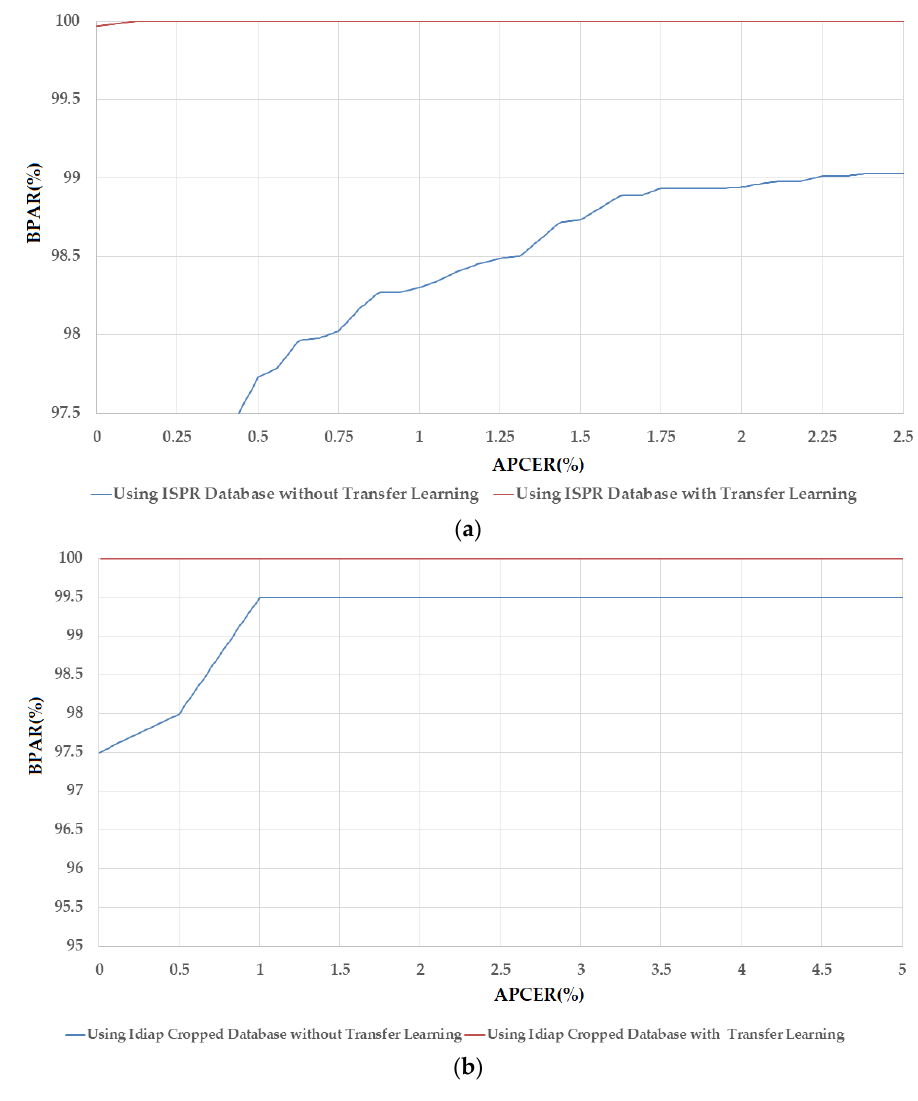
Figure 9. DET curves of various system configurations using our proposed method based on Alex network on two different databases of: ( a ) ISPR-DB database; and ( b ) Idiap Cropped-DB database.